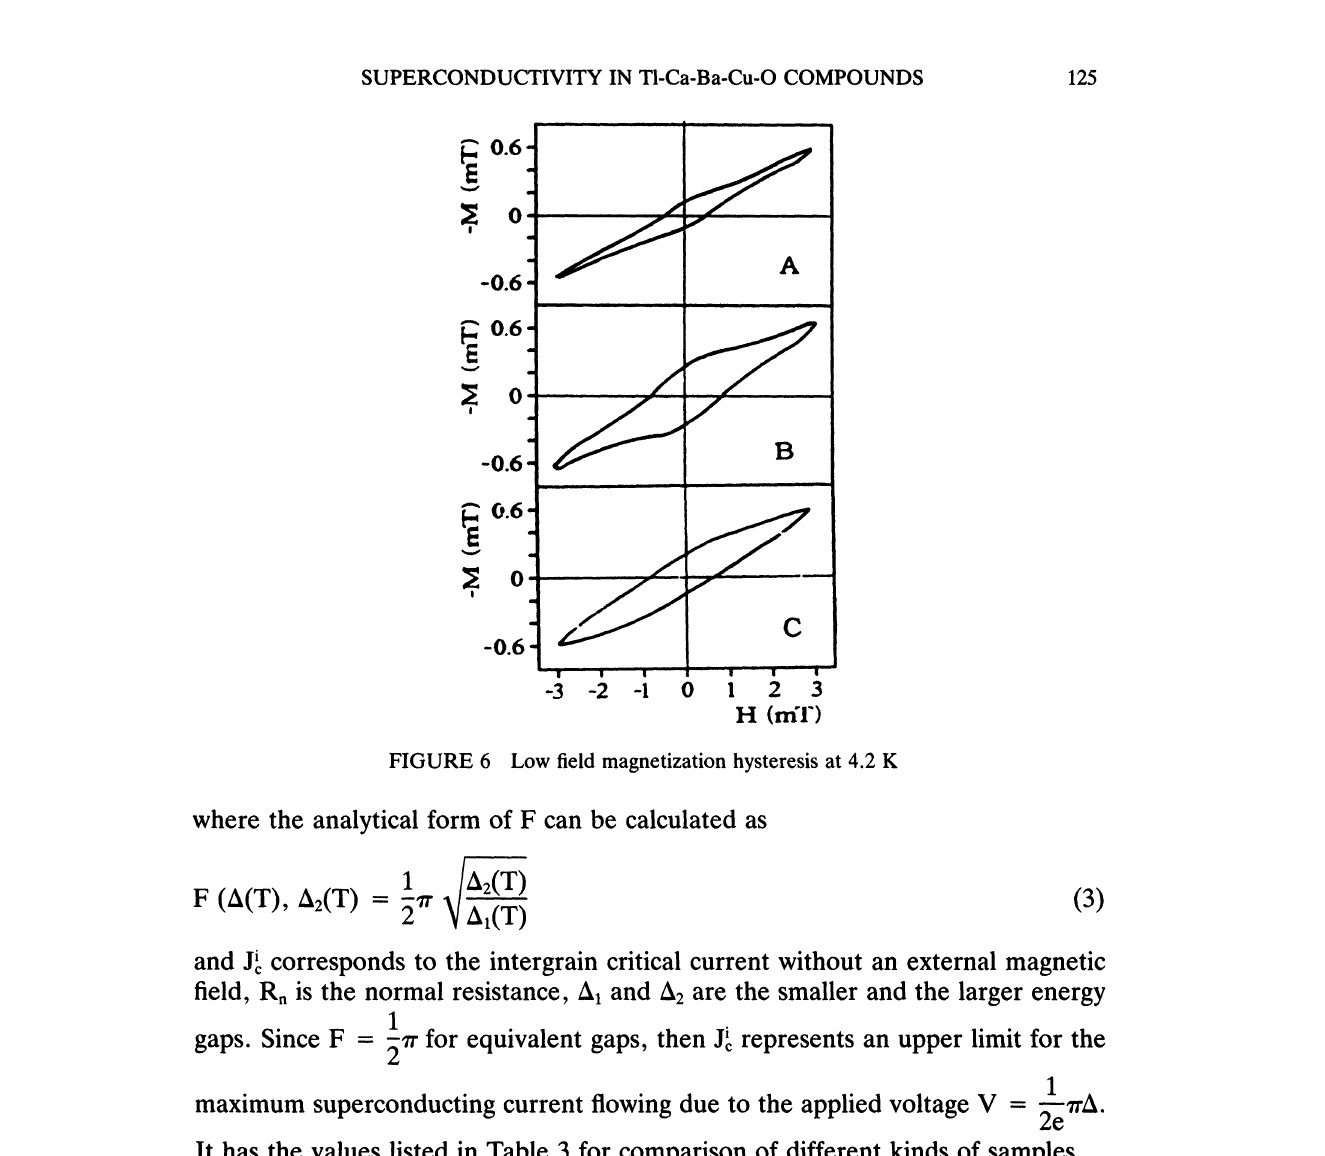
FIGURE 6 Low field magnetization hysteresis at 4.2